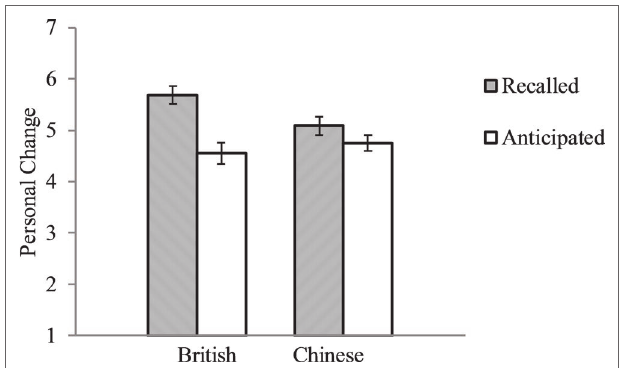
FIGURE 4 | British and Chinese directly reported personal changes in the past 10 years and in the future 10 years. Error bars represent standard